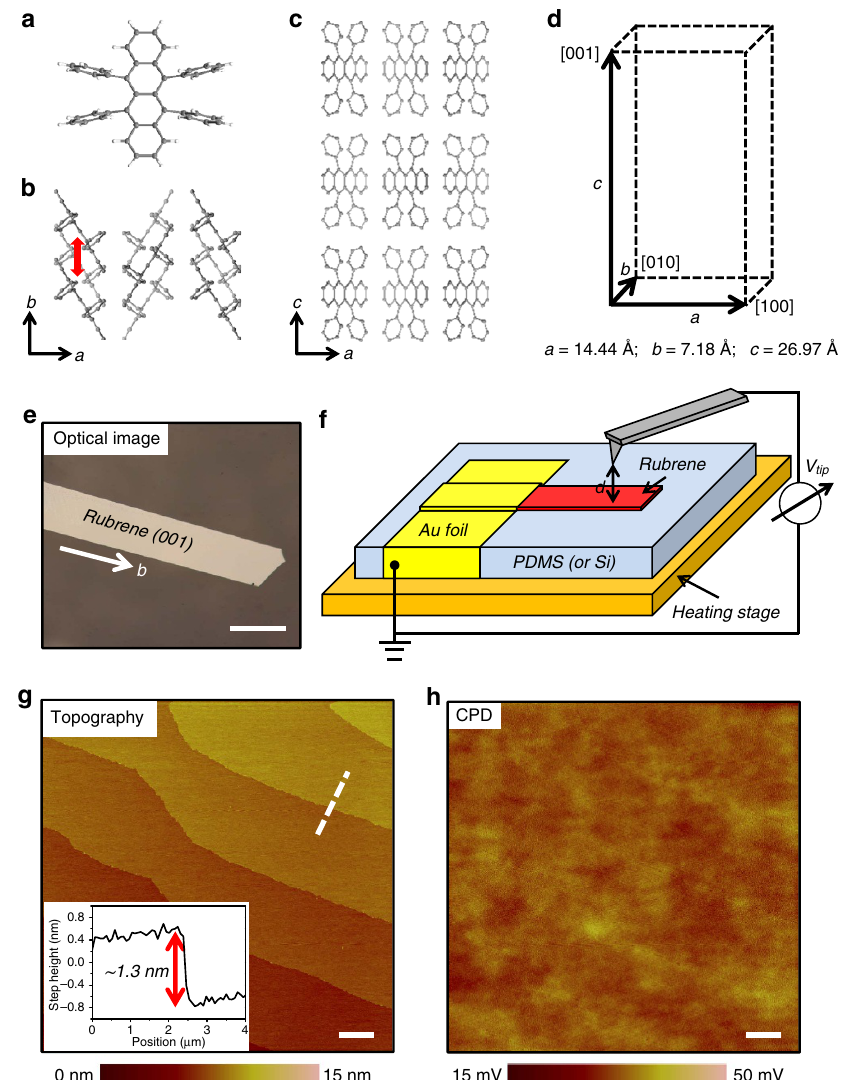
Figure 1 | Crystal structure and SKPM measurement of rubrene single crystals. ( a ) Molecular structure of rubrene. ( b ) Crystal structure in the a-b plane; red arrow indicates the p -stacking interaction. ( c ) Crystal structure in the a-c plane. ( d ) Orthorhombic structure and lattice parameters of rubrene. ( e ) Optical micrograph of as-grown rubrene crystal. Length of scale bar, 200 m m. ( f ) SKPM setup for CPD measurement. The sample sits on top of a heating stage and is grounded through gold foil. The conducting probe scans in a two-pass ‘lift mode’ and a constant lift height ( d ¼ 50nm) is used in the ‘interleave’ pass. ( g ) Topography of rubrene single crystal shows typical terrace structure and each terrace has height corresponding to one molecular layer. Length of scale bar, 2 m m. Inset: step height profile of the dashed line. ( h ) CPD image obtained simultaneously with topography shows nearly homogeneous CPD across the surface. Length of scale bar is 2 m